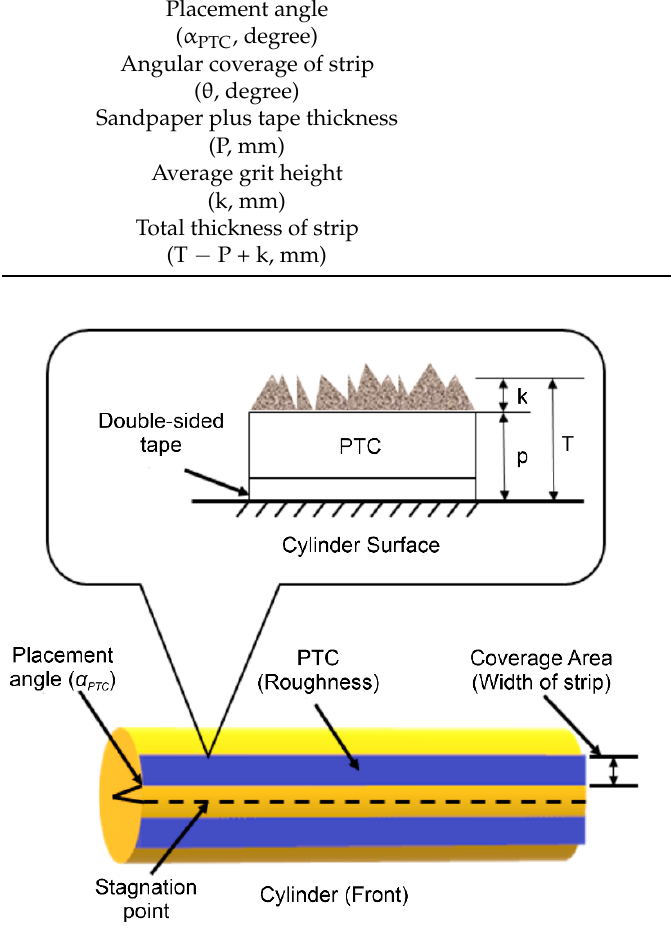
Figure 7. Configuration of passive turbulence control (PTC) on the cylinder [11]. Table 2. Particulars of single-cylinder oscillator model. Table 2. Particulars of single-cylinder oscillator